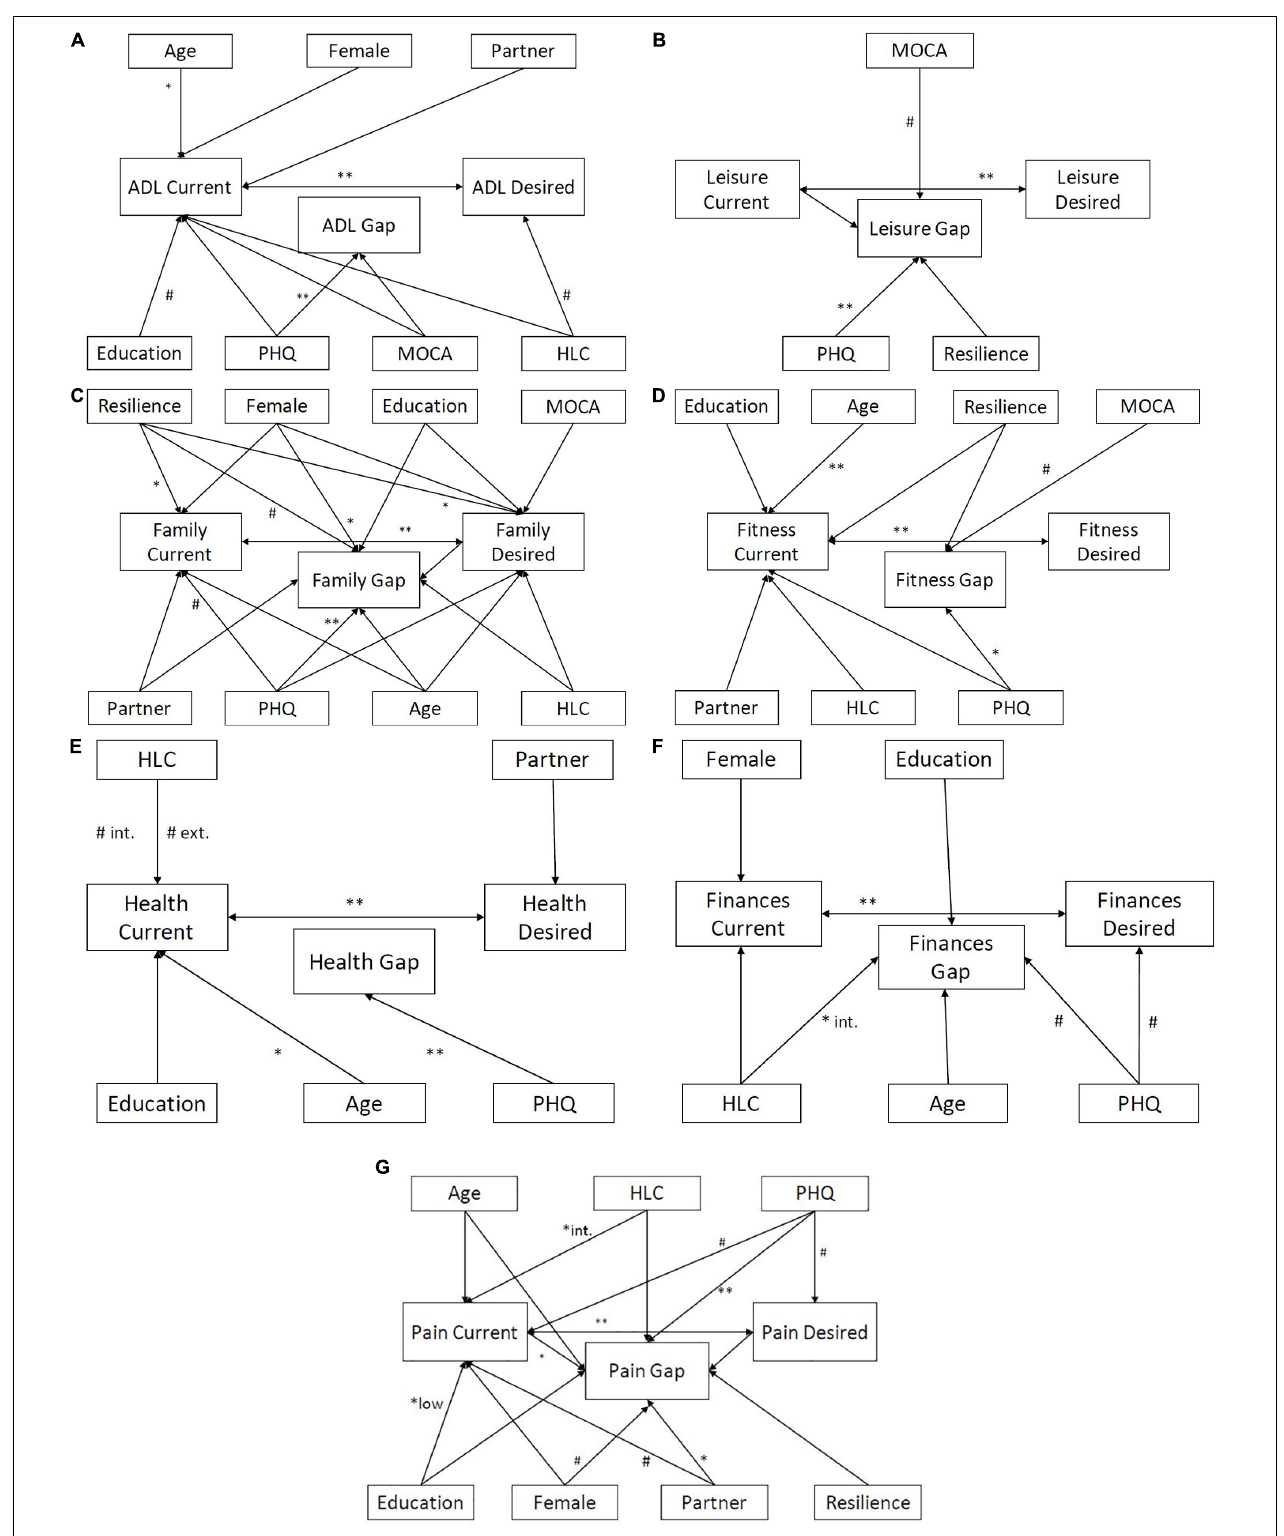
FIGURE 2 | Detailed associations between the current state, desired state, and Calman gap. (A) ADL gap. (B) Leisure gap. (C) Family gap. (D) Fitness gap. (E) Overall health gap. (F) Finances gap. (G) Pain gap. # p < 0.1, ∗ p < 0.05, and ∗∗ p < 0.01 based on Elastic Net models for current, desired and gap; ADL, activities of daily living (int = internal, ext = external); HLC, Health Locus of Control; MOCA, Montreal Cognitive Assessment; PHQ, Patient Health Questionnaire.